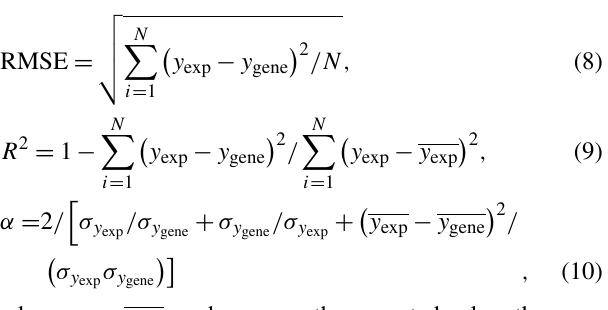
Table 2. Hyperparameter settings of the proposed LSTM networks. Hyperparameter Value or method Number of input, hidden, and output layer(s) (1, 1, 1) Number of input, hidden, and output neuron(s) (1, 1–100, 1) Initial weights and biases of all neurons U ( − 0 . 5, 0.5) ∗ Initial cell states of LSTM neurons 0 Optimizer and learning rate RMSprop (Hinton et al., 2020), 0.001 Loss function Mean square error